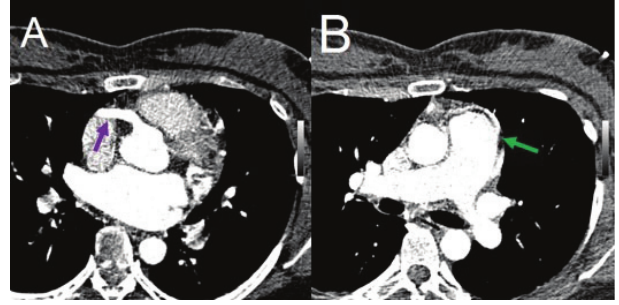
Figure 1. A – Arrow – RCA dilated arising from the aorta. B – Arrow – LMA arising from lateral aspect of the MPA.